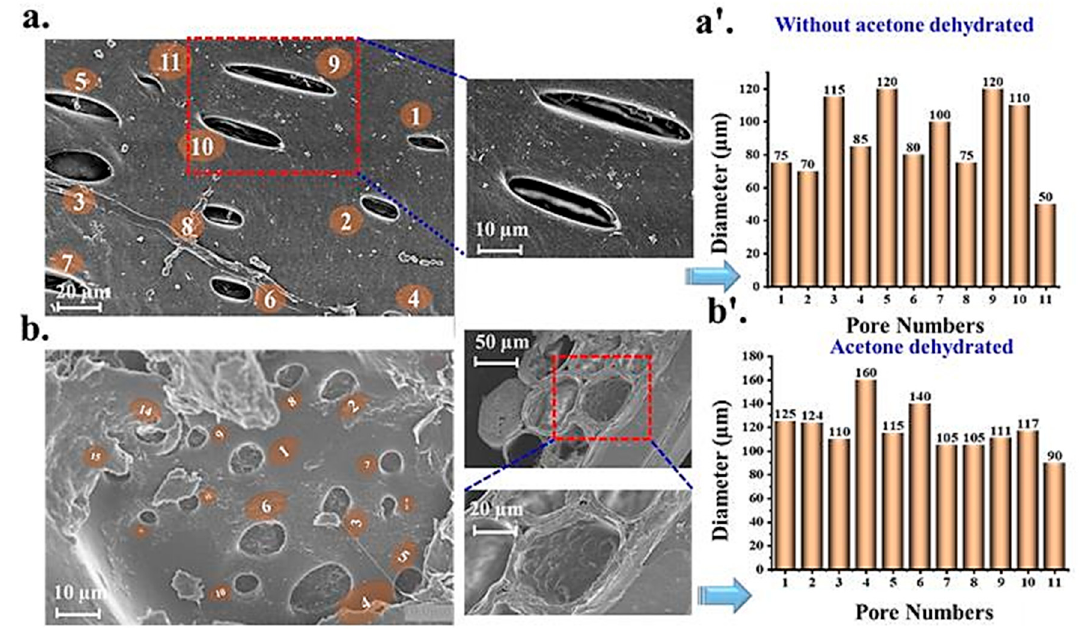
Figure 4. The level of interaction between biofilm and solid-state electrodes, in terms of spatial dispersion, thickness, and morphology, as studied by SEM analysis. SEM photograph of SPHHs. ( a ) Non-acetone dehydrated freeze-dried, single pore of sample; ( a’ ) average pore diameter non-acetone dehydrated; ( b ) acetone dehydrated oven-dried, single pore of the sample; ( b’ ) average pore diameter, acetone dehydrated.